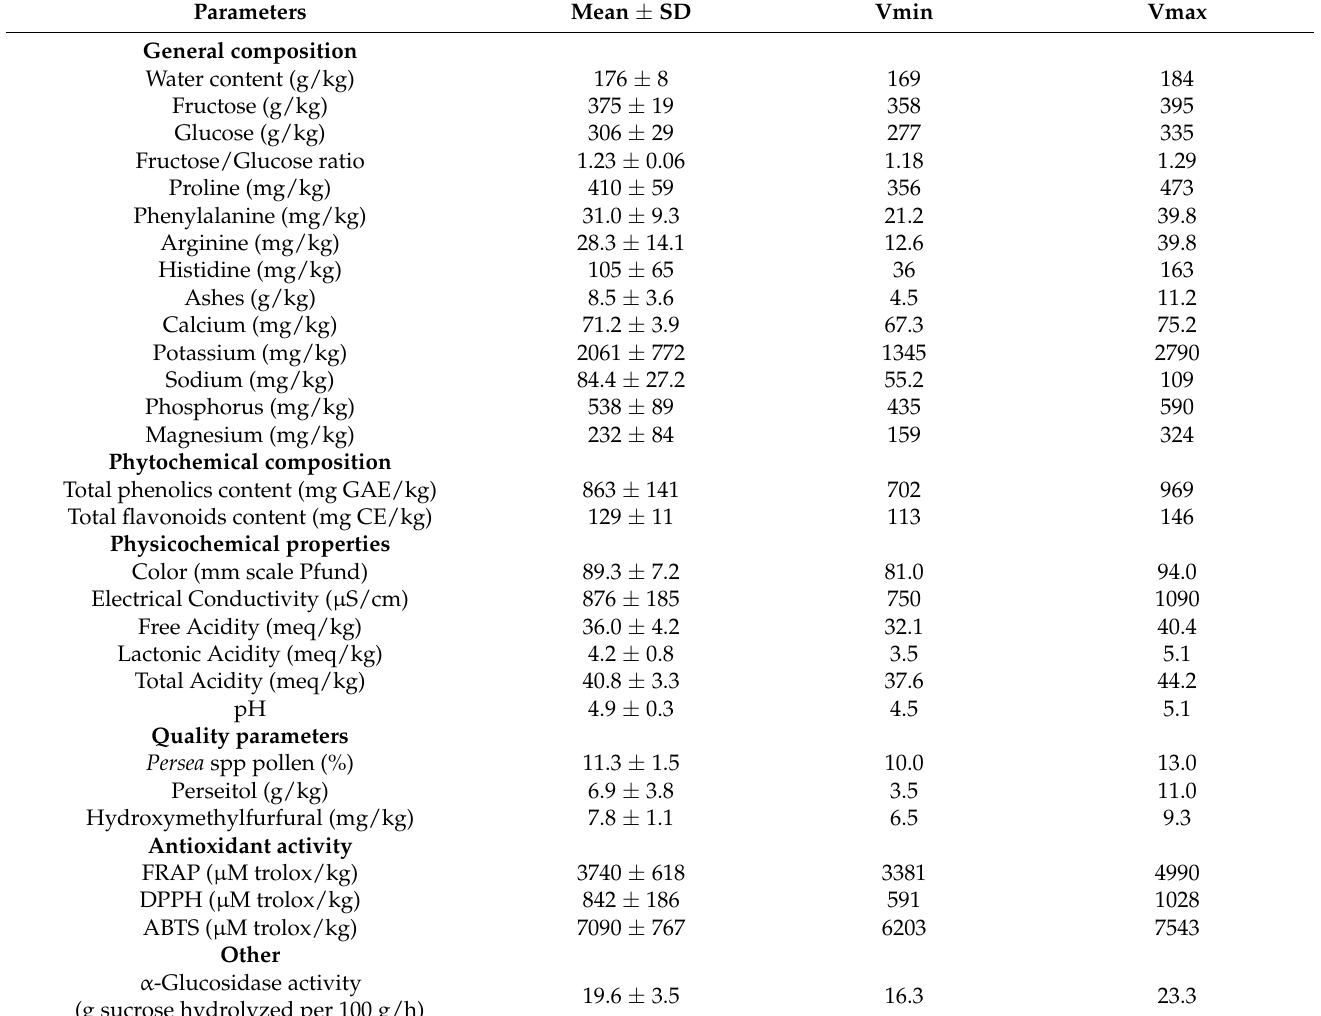
Table 2. Avocado honey composition, physicochemical properties, and antioxidant activity.